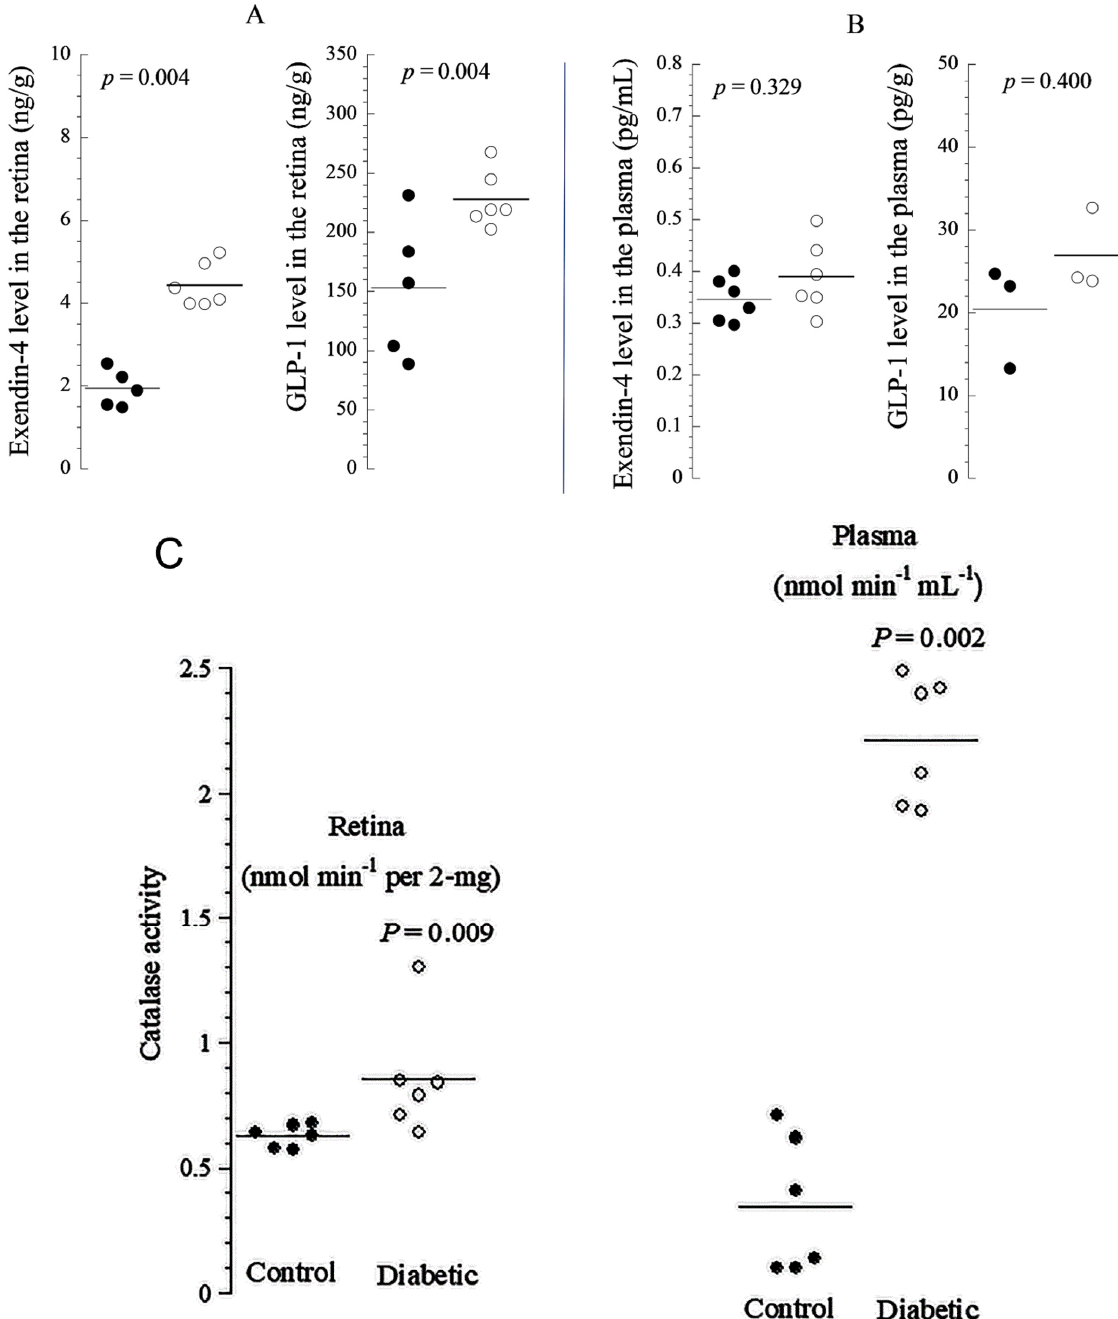
Figure 3. Enzyme-linked immunosorbent (ELISA) assays of EXE-4 and GLP-1 in the retina ( A ) and plasma ( B ) of non- diabetic retinas (filled circles) and diabetic retinas (unfilled circles); number of independent measurements = 3–6). ( C ) Retinal and plasma concentration of catalase (CAT). The value of p is based on non-parametric, 2 independent samples (Mann–Whitney) test. The horizontal lines represent the mean. Thus, the levels of incretins are significantly higher in the retinas of diabetic rats. Note that the retinal and plasma concentration of CAT is significantly higher in the plasma and diabetic rat retinas compared to controls.